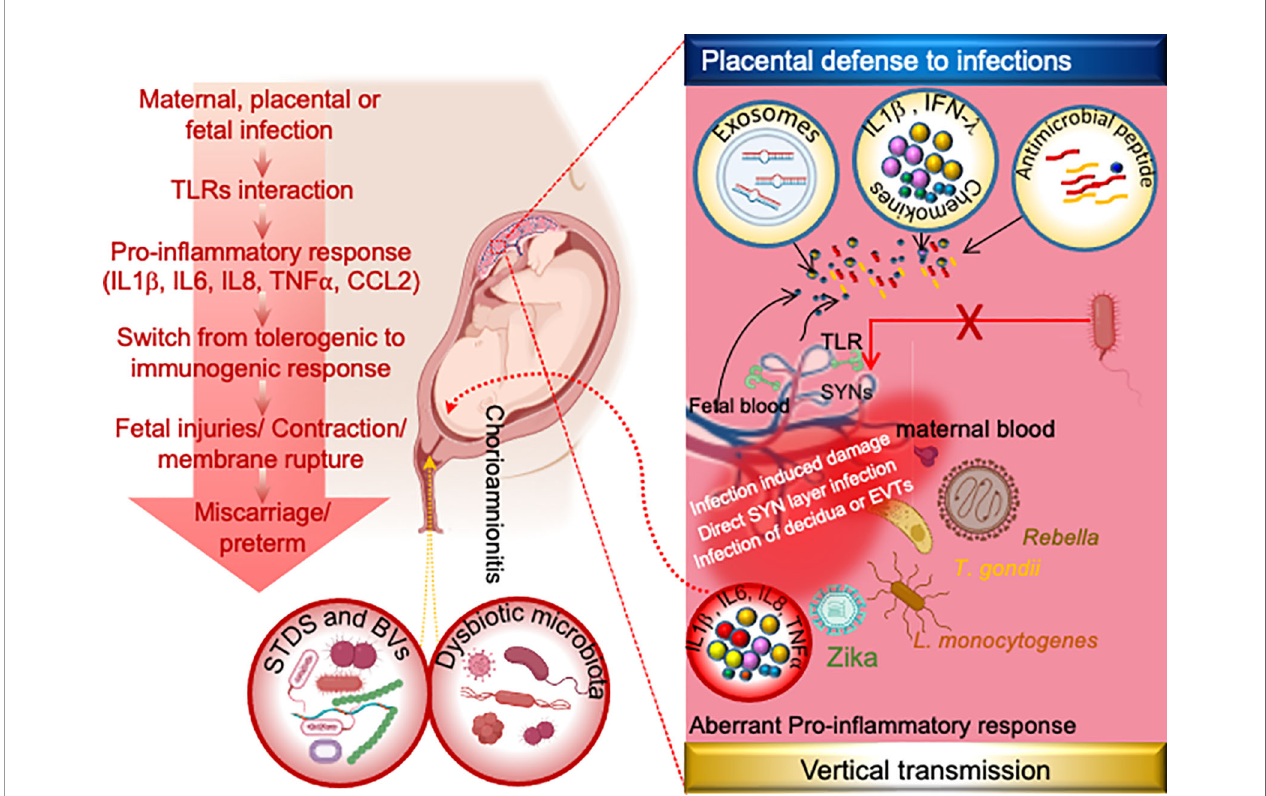
FIGURE 2 | Mechanism of placental physical and immune defense and possible mechanism of vertical transmission of TORCH and other pathogens during pregnancy. The human placenta has evolved several layers of defense including antimicrobial effectors such as exosomes, antimicrobial peptides, and/or innate immune response to infection by release of cytokines and/or highly integrated syncytiotrophoblast. Syncytiotrophoblast is the placental barrier between maternal and fetal blood that allows selective exchanges in nutrients and gases between the embryo and the mother but inhibits the microbial invasion. Although the exact mechanisms by which TORCH pathogens cross the placental barrier are still unclear. However emerging studies indicates these pathogens reach the fetus through infected maternal decidua, infected extracellular trophoblasts (EVTs) and/or through direct infection of the syncytium, while the vaginal pathogens gain access to the amniotic cavity via ascending transmission. Following the amniotic cavity infection, toll-like receptors (TLRs) at the fetal-maternal interface get activated and induce pro-in fl ammatory cytokines and chemokines, leading to further immune cells recruitment. Switching of maternal immune response from tolerogenic to in fl ammatory state leads to the premature activation of cervical ripening proteins and onset of labor. Common STDs and BVs infections are C. trachomatis, N. gonorrhoeae, T. pallidum, GBS, E. coli etc. Dysbiotic microbiota infections are GBS, E. coli, C. trachomatis, Gardnerella, Prevotella etc. EVTs: Extravillous trophoblasts, GBS: Group B Streptococcus, SYNs: